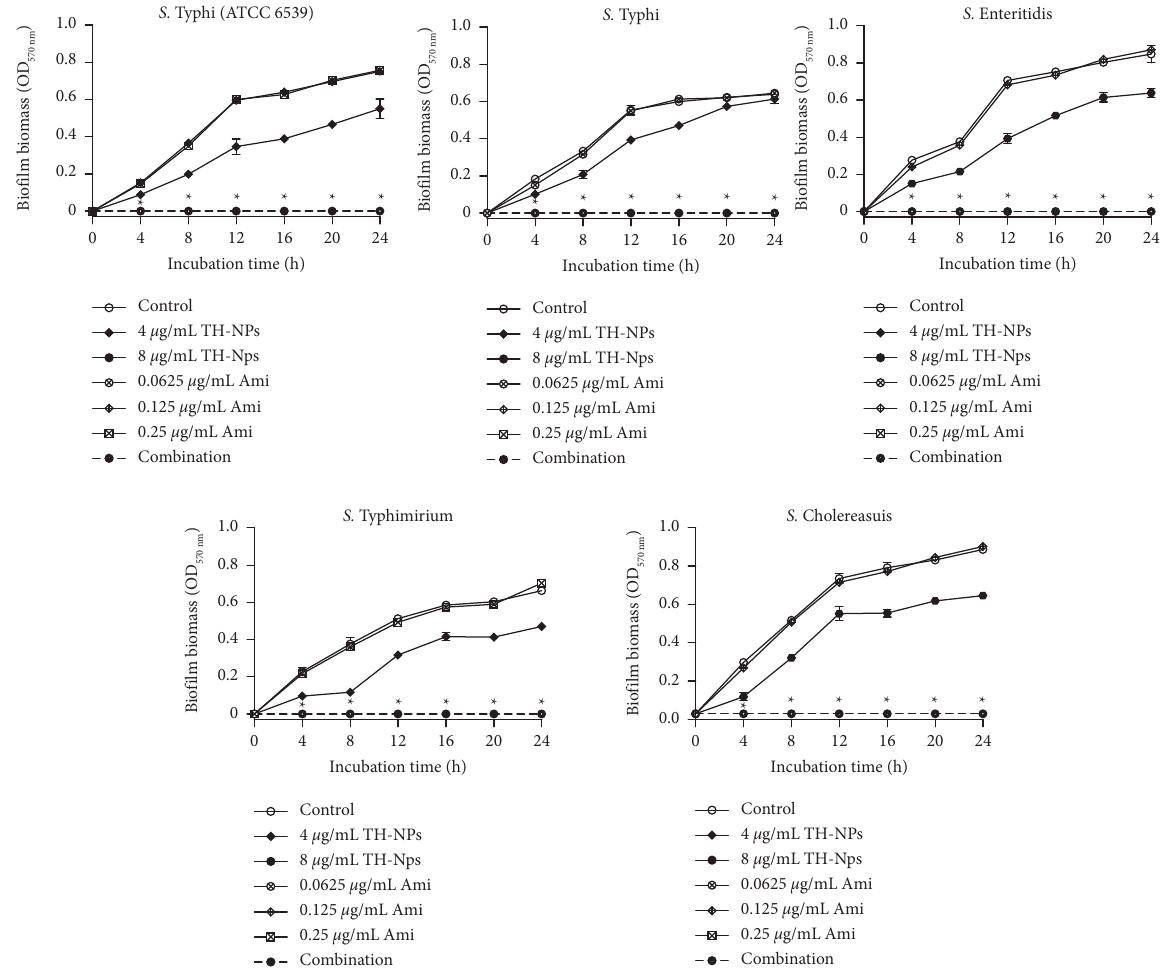
Figure 2: Kinetic study of TH-NPs and amikacin alone or in combination against bioflm biomass formation of S. enterica serovars. TH- NPs: thymol-loaded PLGA nanoparticles; Ami: amikacin. Data represent the average values and standard deviation of three independent experiments. ∗ Signifcant diference between the combination and TH-NPs alone ( p <